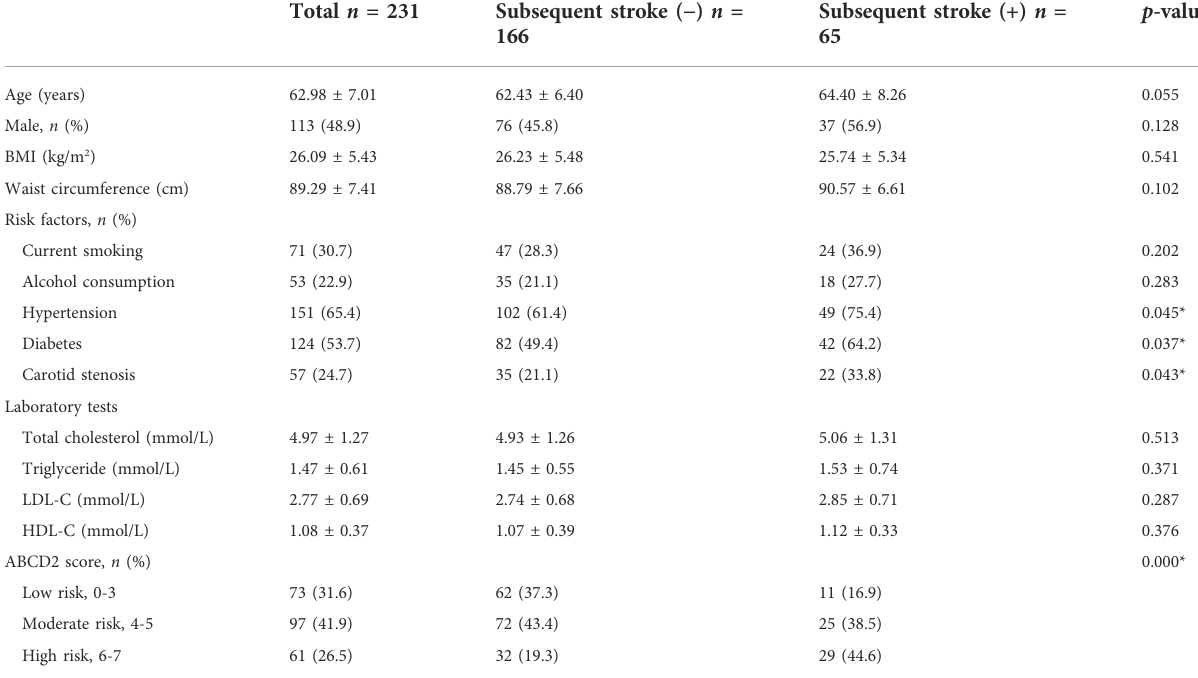
TABLE 1 Baseline characteristics of the subjects.